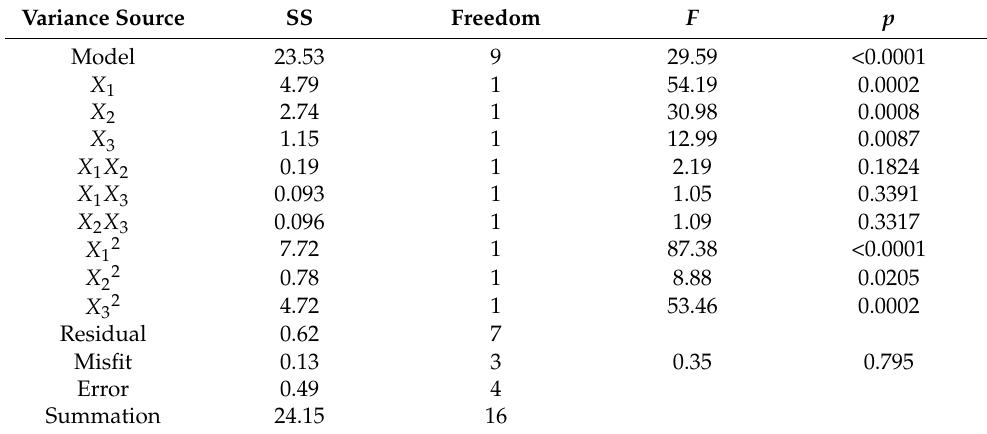
Table 5. ANOVA of missed seeding rate.